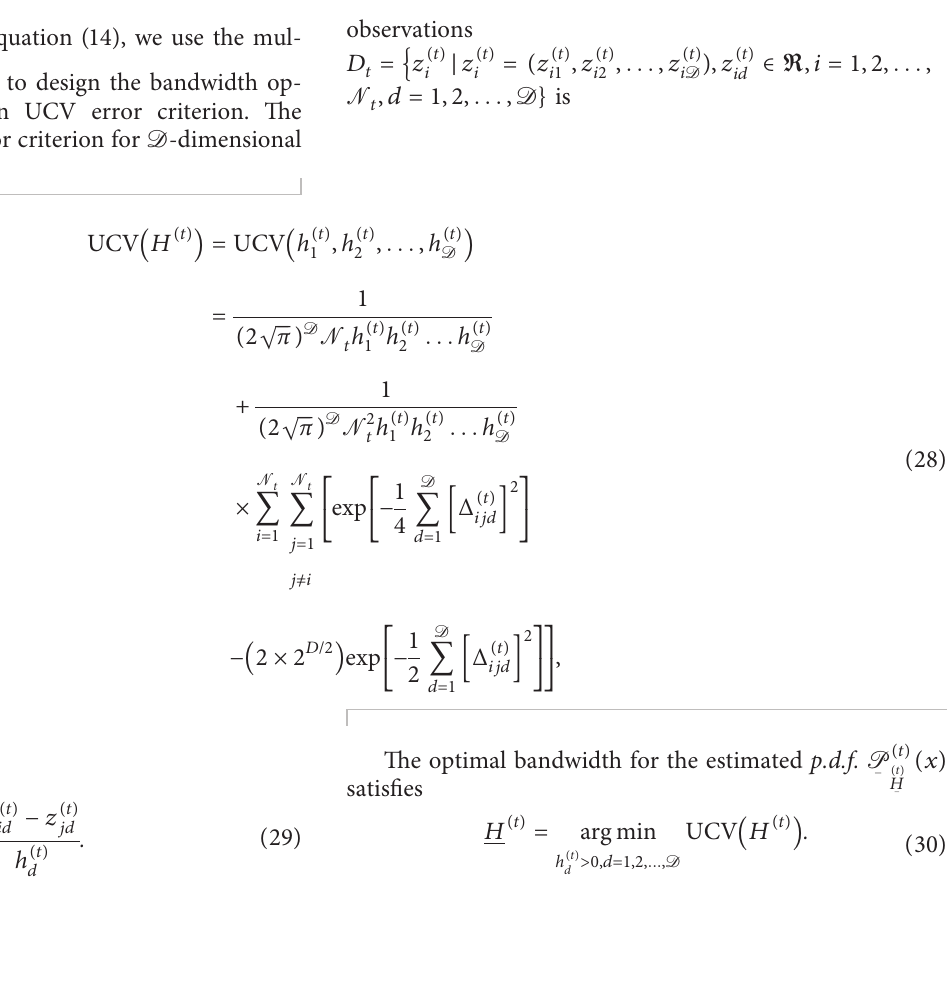
Figure 2: The comparison of time complexity between the I-KDE and retraining scheme. Let T � 10, D � 10, and N 2 , . .. , T in the experimental simulation. The time complexity of the I-KDE is far less than the time complexity of retraining